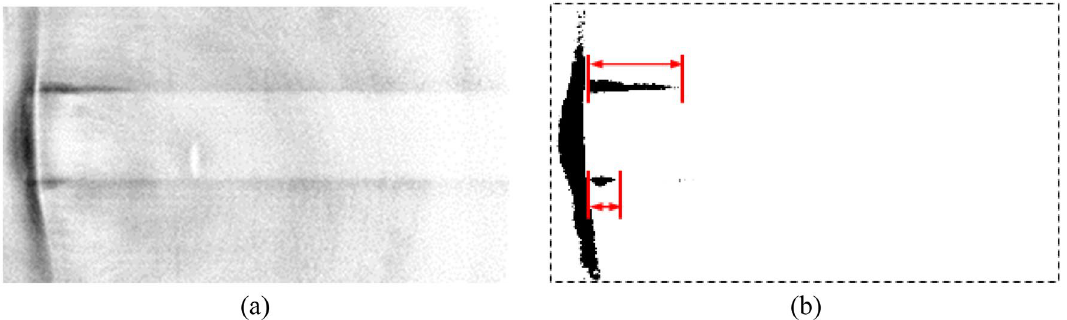
Figure 10. ( a ) Transmission image obtained during nano-CT imaging from the same angle as that in Fig. 9a, and ( b ) debonding length extracted using the binarization process. Distinguish the short interfacial debonding from the sample surface is still